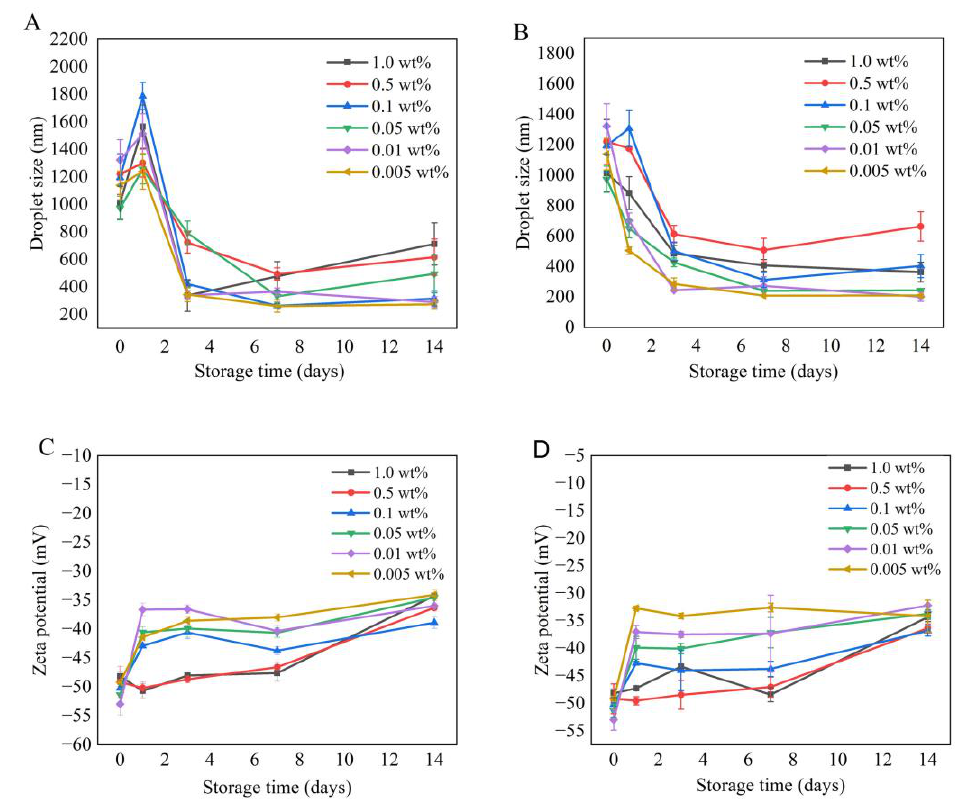
Figure 4. Effects of storage time and temperature on droplet size and zeta potential of emulsions with different concentrations of TEMPO-oxidized ChNCs at pH 7: ( A ) change in droplet size at 4 ◦ C; with different concentrations of TEMPO-oxidized ChNCs at pH 7: A . change in droplet size at 4 °C; ( B ) change in droplet size at 25 ◦ C; ( C ) change in zeta potential at 4 ◦ C; ( D ) change in zeta potential at B . change in droplet size at 25 °C; C . change in zeta potential at 4 °C; D . change in zeta potential at 25 ◦ 25 °C.